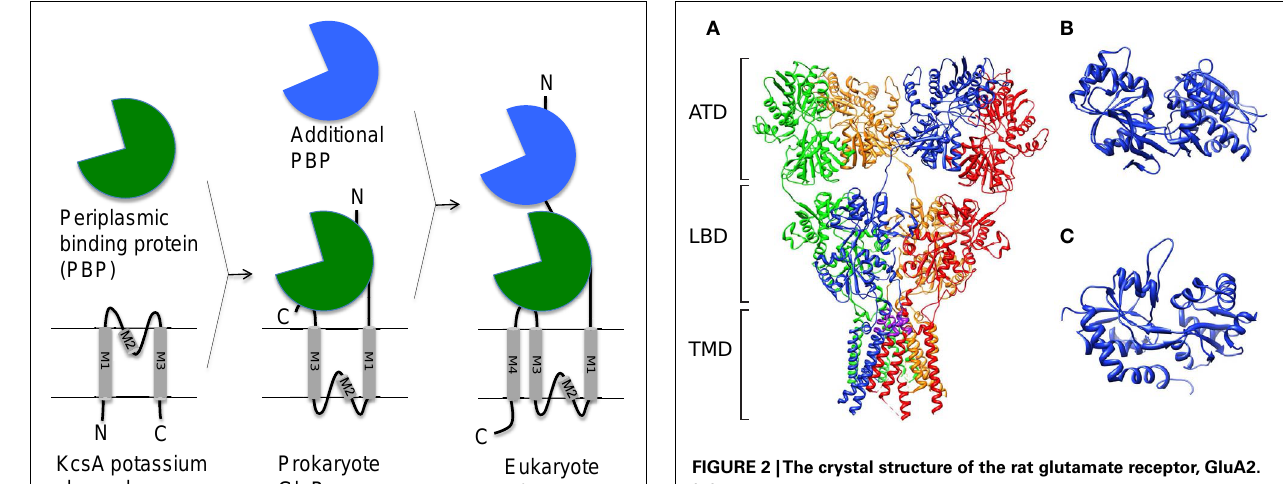
FIGURE 2 |The crystal structure of the rat glutamate receptor, GluA2. (A) Structure of the intact channel (3KG2; Sobolevsky et al., 2009). Four subunits are shown in different colors.The “SYTANLAA” motif, which consists of the narrowest part of the channel in each subunit, is marked in purple. (B,C) The structures of isolated ATD (3H5V; Jin et al., 2009) and LBD (2UXA; Greger et al., 2006), respectively. Note the “venus-flytrap” like structure in both